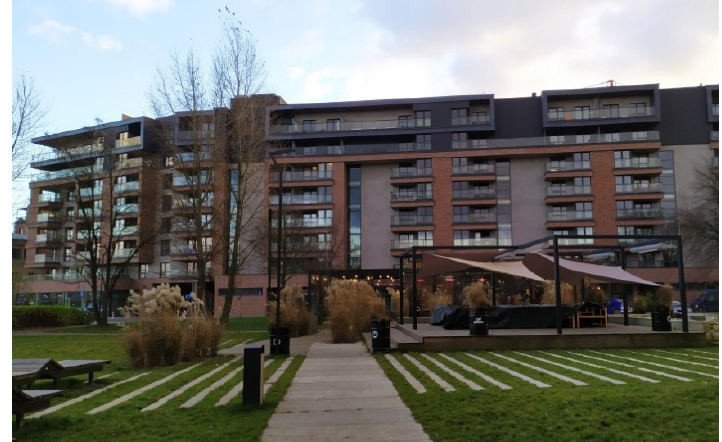
Figure 16. Park Vistula Station (Park Stacja Wisła), designed by Michał Grzybowski. In the background, residential building ATAL Residence Kraków, designed by Biuro Rozwoju Krakowa S.A. (Item 10, Figure 1), (photo by E. Latusek).